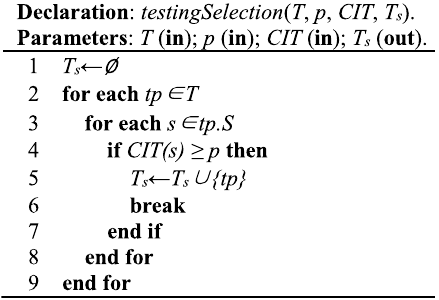
Algorithm 4 Test case selection algorithm based on the existent satisfaction strategy